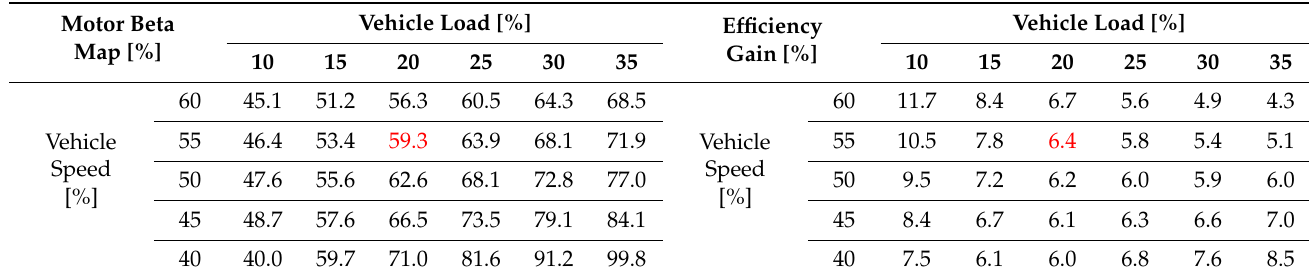
Table 5. Optimal motor displacement and efficiency gain for different working conditions (Solution B).The number in red represents the operation point shown in the above section. Motor Beta